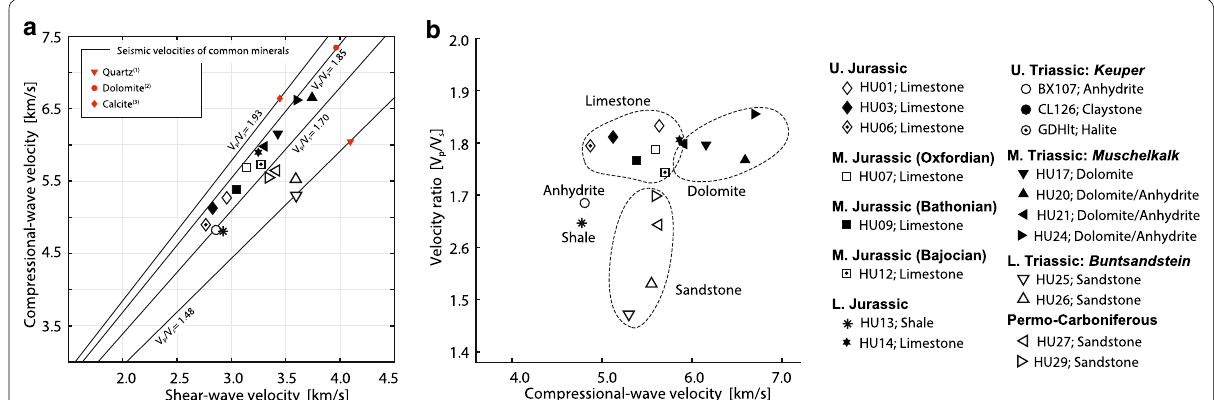
Fig. 14 A cross-plot of average compressional- versus average shear-wave velocities with isolines for Vp/Vs ratio of different common minerals. The compressional and shear wave velocities for such minerals were after (1) Carmichael (1990), (2) Humbert and Plicque (1972), (3) Chen et al. (2001). (B) Clusters of rock-types based on the plotting of the seismic velocity ratio vs. the compressional-wave velocity. Similar clustering pattern was found for shear-wave velocity. Error bars are within